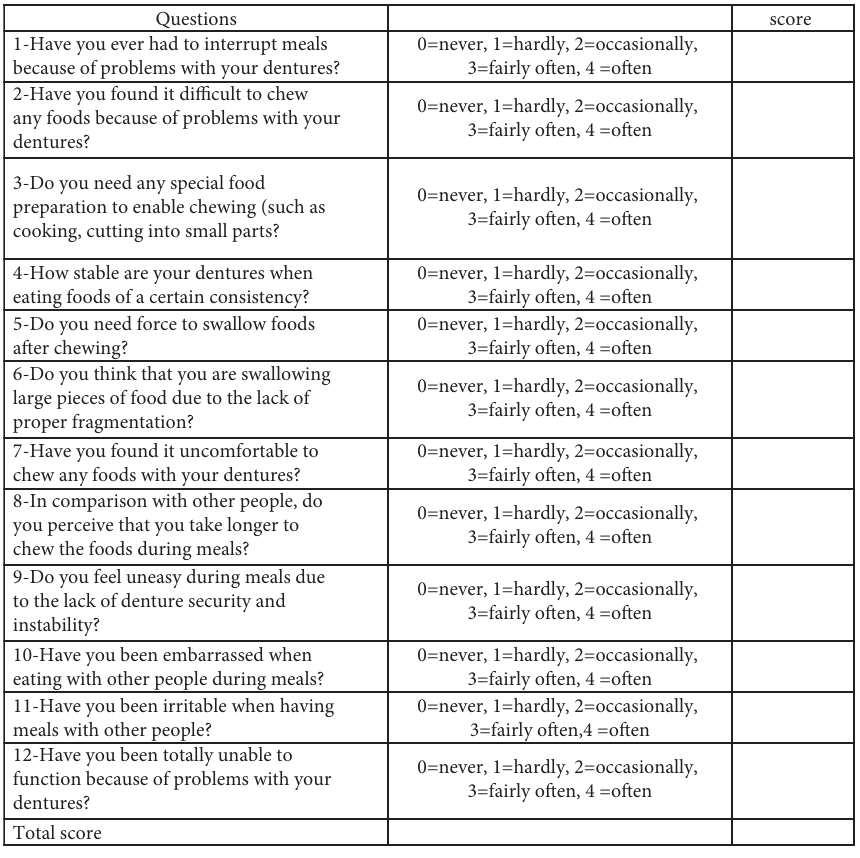
Figure 1: Masticatory ability [30] consists of 12 questions, and each question has options with the best score being 0 and worst score being 4; a total score was calculated for each